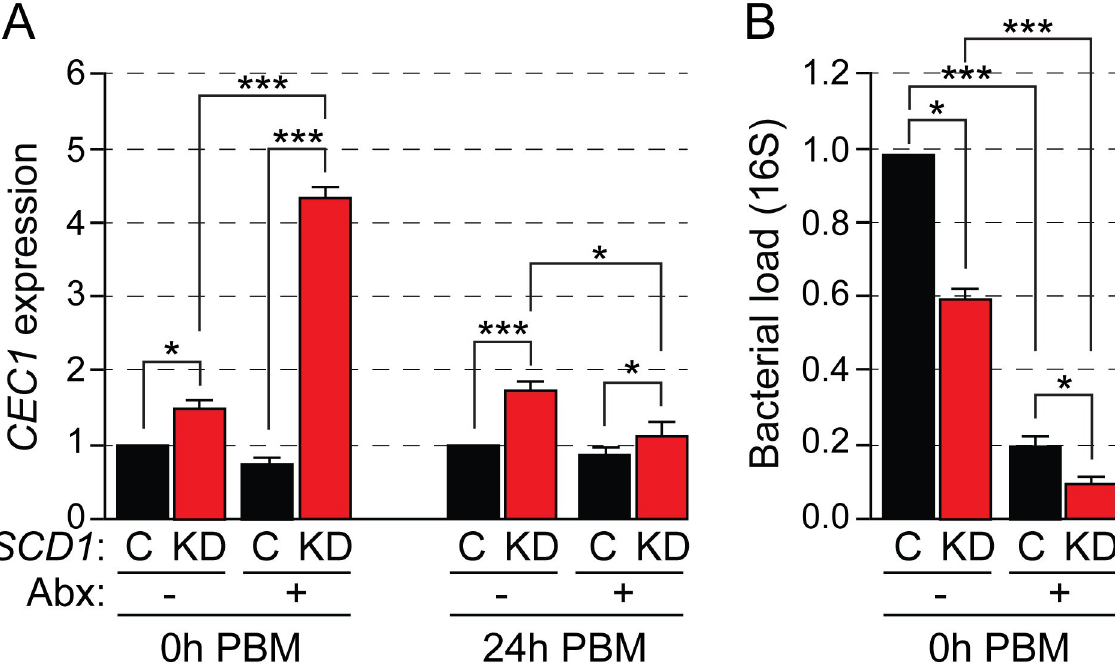
Fig 6. Impact of gut microbiota on immune activation in SCD1 KD mosquitoes. ( A ) Relative expression of the AMP CEC1 expression in dsLacZ-injected (C) and SCD1 KD (KD) adult mosquitoes fed on sugar (-) or sugar plus antibiotic (Abx; +) solution since emergence. After five, mosquitoes were sampled either without further treatment (0h PBM) or after they have been provided a blood meal (24h PBM). ( B ) Bacterial load in the midguts of mosquitoes treated as above, measured by qRT-PCR of 16S rRNA. Reported values are the mean ± SE of three independent biological experiments of 10 mosquitoes per group. ��� p < 0.0001, � p < 0.01.